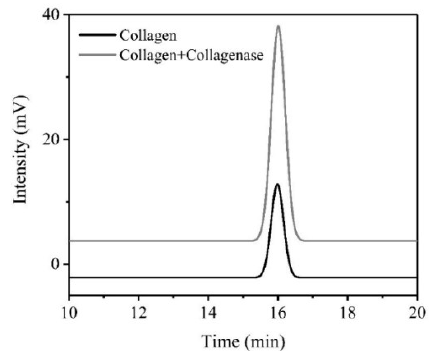
Figure 4. High-Performance Liquid Chromatography (HPLC) chromatogram of dialysate of collagen before and after reaction.